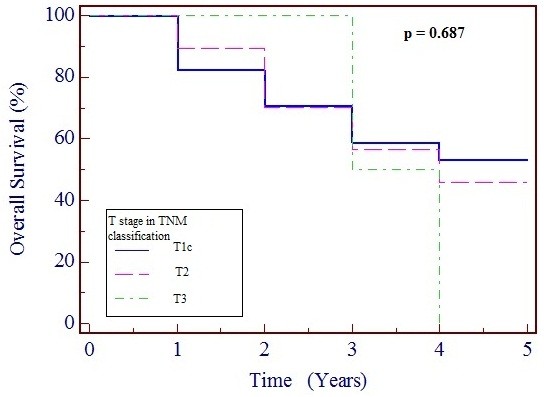
Kaplan–Meier survival curve based on tumor stage, showing 95% confidence interval (CI).p < 0.5 is considered statistically significant.